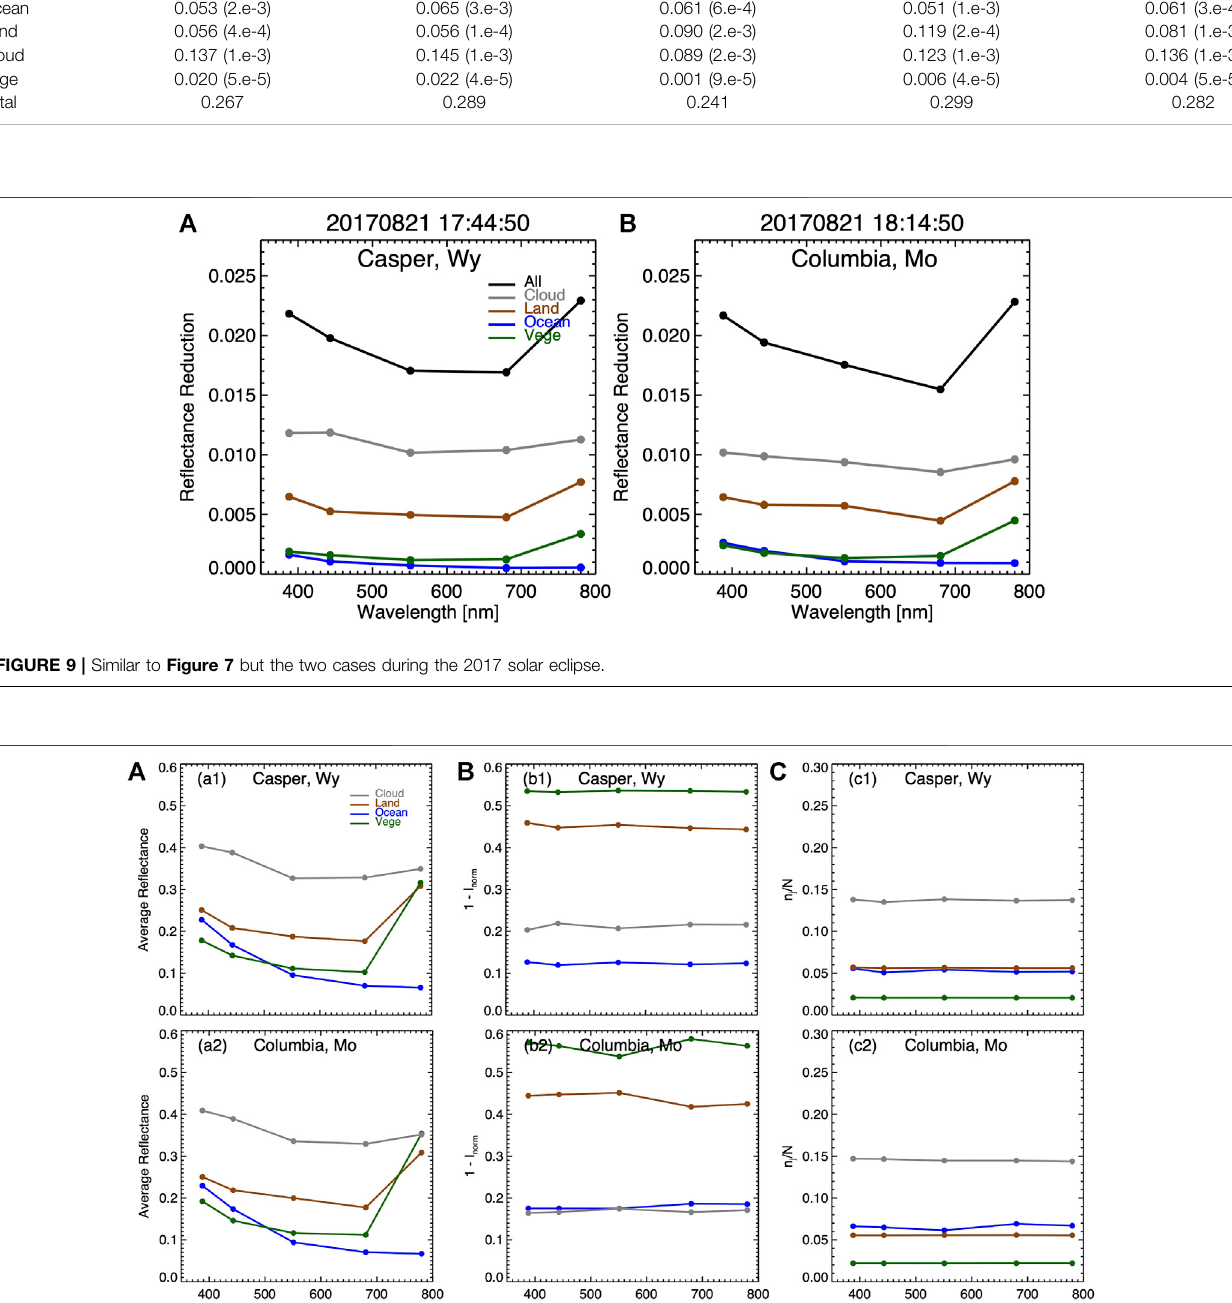
Frontiers in Remote Sensing |